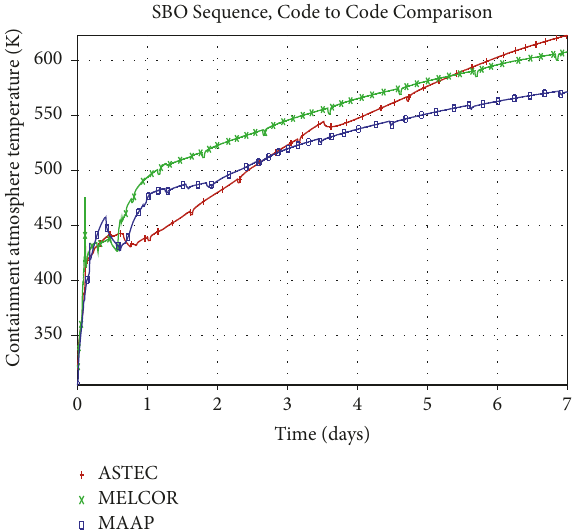
Figure 7: Temperature in the containment upper dome.